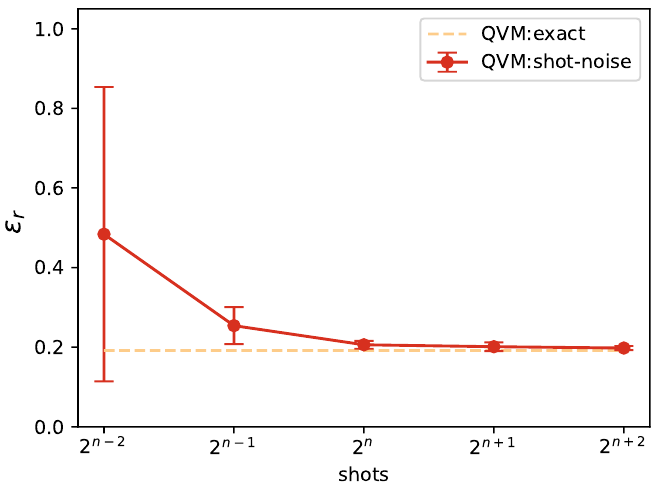
Figure 7: Relative error of the optimized QAOA output distribution (y-axis), as a function of number of shots (x-axis), for a problem instance of the n = 5 case. Circles indicate median, and we plot the error-bars (using MAD) when approximating the expectation value with a finite number of shots. QVM:shot-noise refers to the values after the shot-noise optimization and QVM:exact denotes the relative error found after noiseless statevector optimization and is ≈ 0.2. The QAOA depth for all values in the plot is p = 1. Data represented in the figure is an output of an experiment done in Section